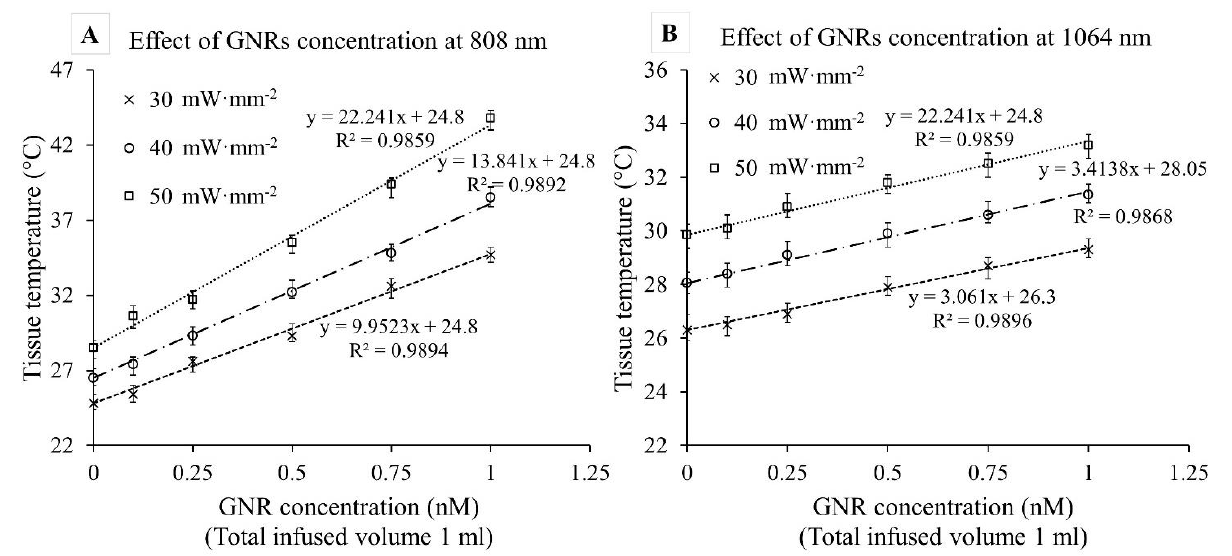
Figure 8. Ex vivo porcine pancreas tissue temperature vs. GNR concentration graphs for three different laser irradiations (30, 40, and 50 mW·mm −2 ) at ( A ) 808 nm and ( B ) 1064 nm wavelengths. Laser exposure time was fixed at 60 s. Error bars represent mean ± 1 σ (standard deviation) for n = 5 trials. Statistical analysis (T-test) between tissue temperatures from different irradiations for a fixed wavelength and GNR concentration showed the significance of the data ( p < 0.01).